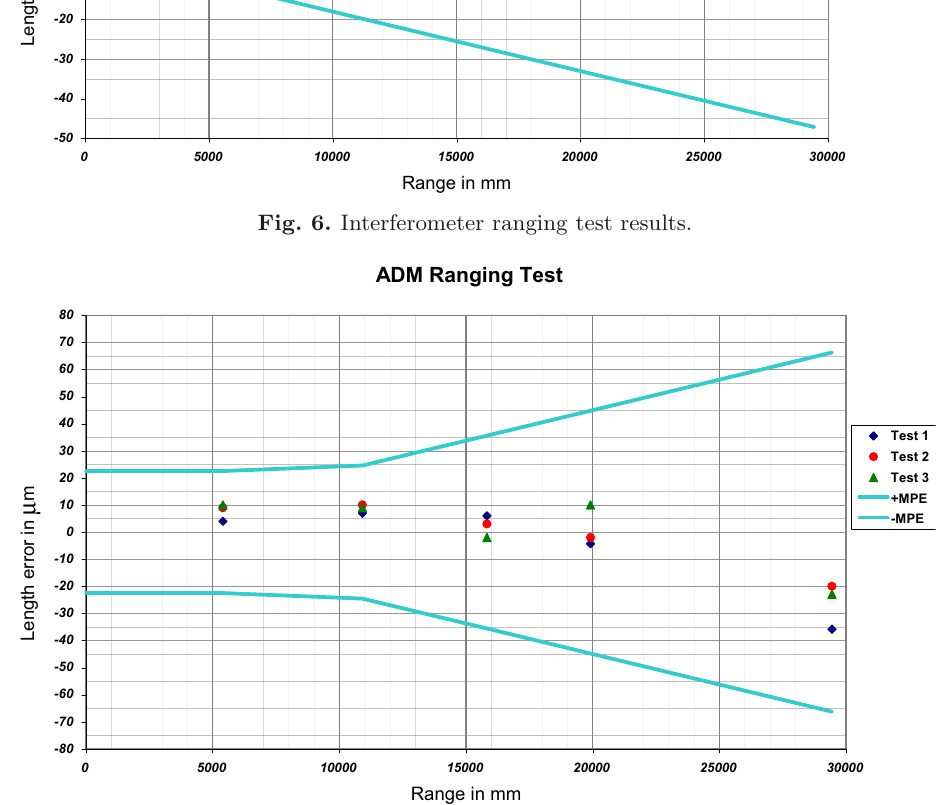
Fig. 7. ADM ranging test